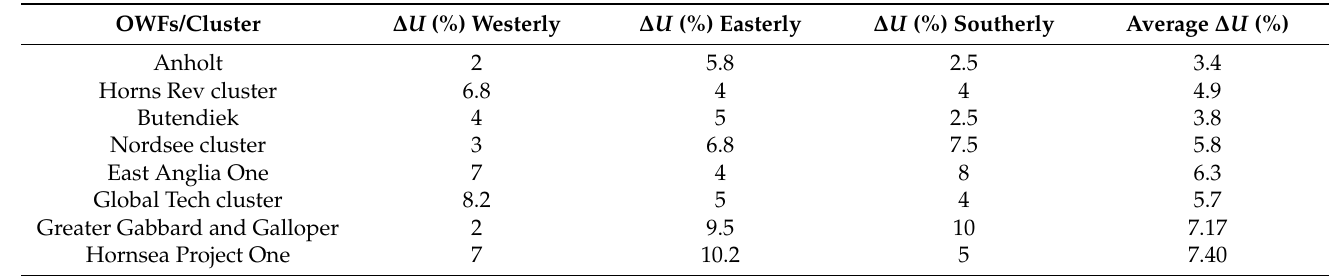
Table 4. Maximum velocity deficit ( ∆ U ) detected within the first 5 km downstream of the OWFs and clusters.